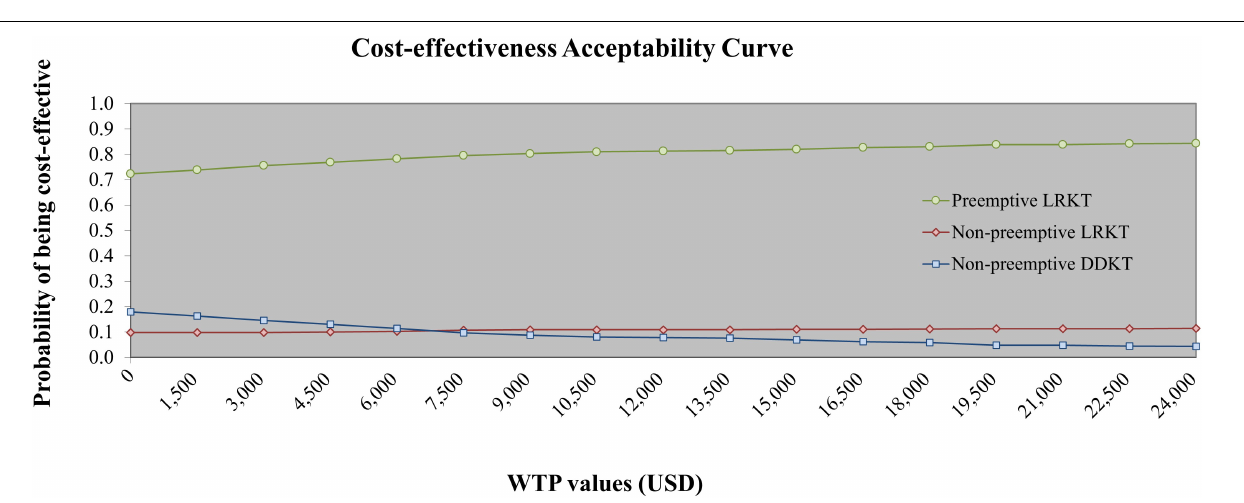
FIGURE 3 | Cost-effectiveness plane of preemptive LRKT and non-preemptive LRKT versus non-preemptive DDKT. NP-DDKT, non-preemptive deceased-donor kidney transplantation; NP-LRKT, non-preemptive living-related kidney transplantation; P-LRKT, preemptive living-related kidney transplantation.